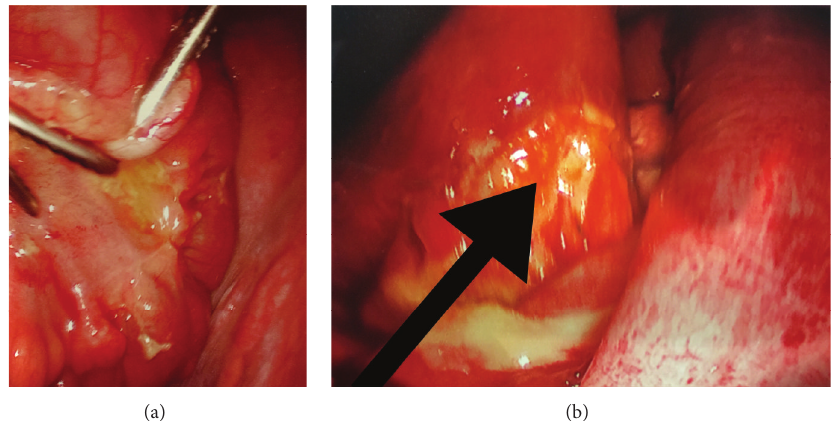
Figure 2: Laparoscopic views of the inflamed and perforated small bowel photographed prior to the conversion to laparotomy. (a) The photograph demonstrates a highly erythematous, inflamed segment of small bowel with fibrinous exudation and inflammation adjacent to the instrument. (b) The arrow pointing to the site of perforation located at the approximate jejunal-ileal